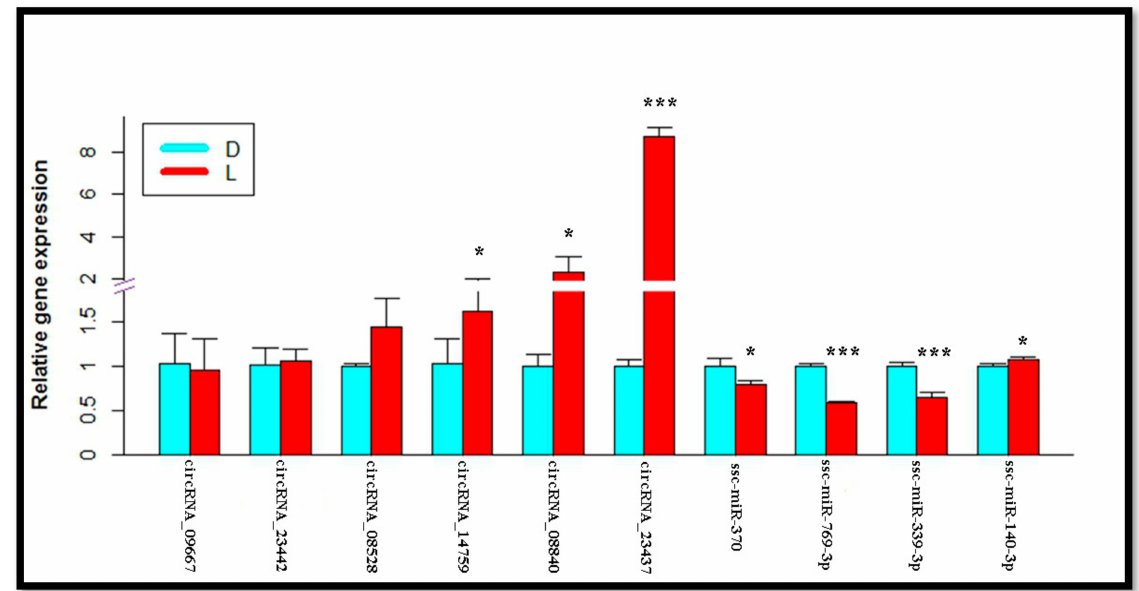
Figure 11. The qRT-PCR verification result of differentially expressed circRNAs, miRNAs in the longissimus intramuscular adipose tissues of the Large White and Laiwu pigs (L_JN vs. D_JN). Significance of the correlation: * means p < 0.05, *** means p <